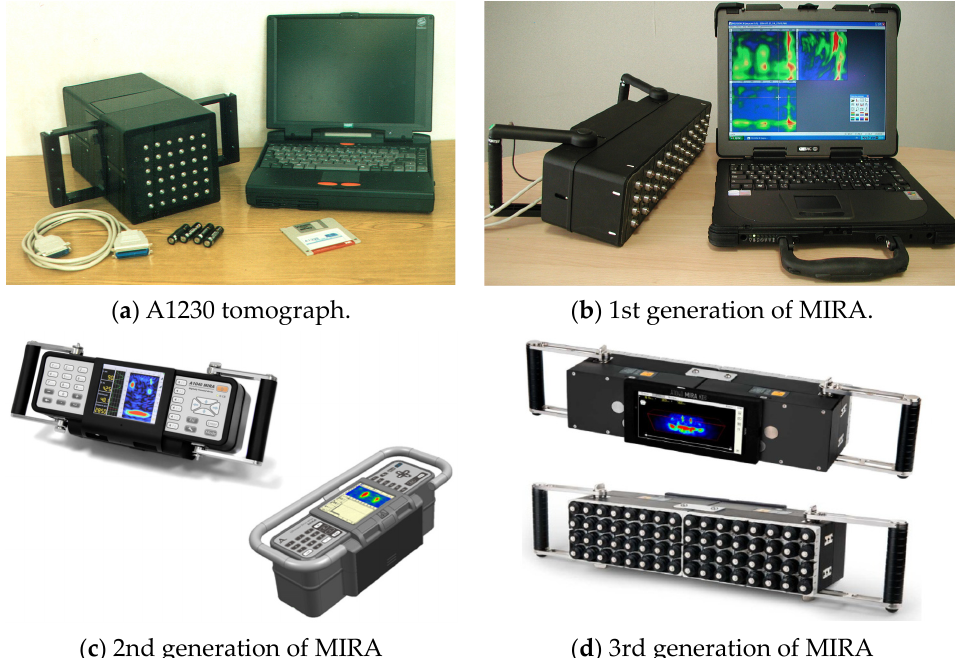
Figure 2. Various versions of ultrasonic shear wave devices (courtesy of ACS